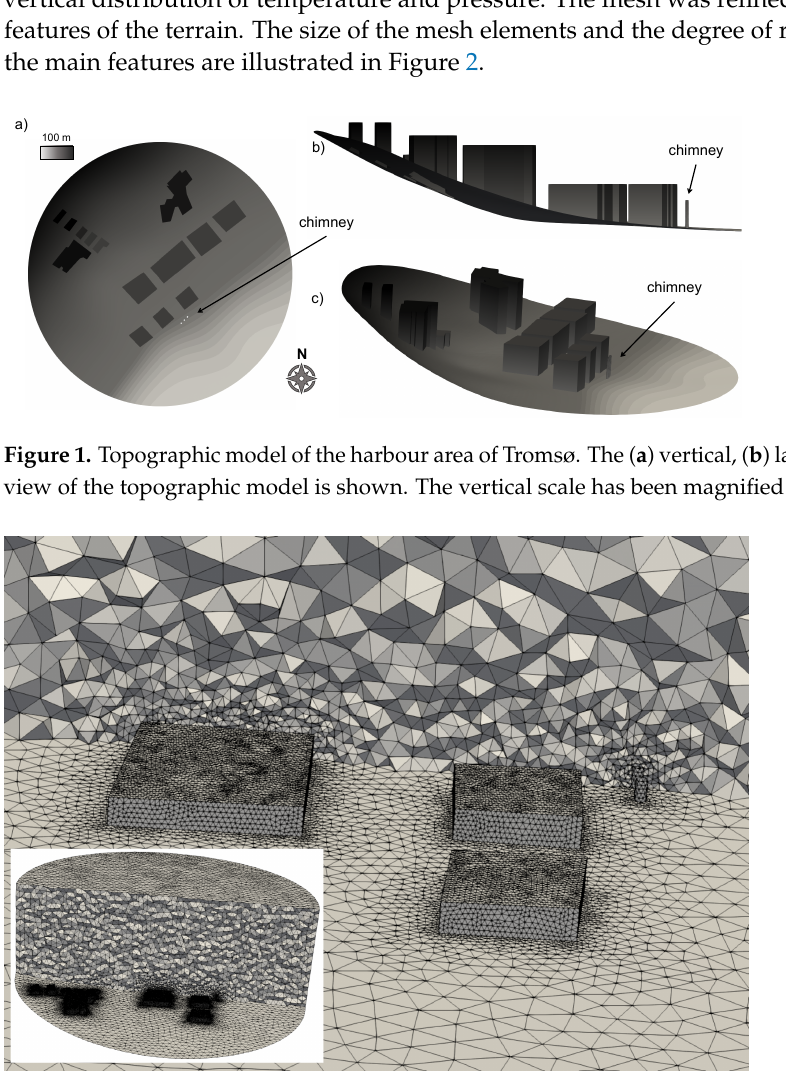
Figure 2. Tetrahedral mesh. Detail of the tetrahedral mesh used for the CFD simulation around the main features of the terrain. The inset shows a clip of the mesh along a plane extending along the north-west ( − 1,1,0 )